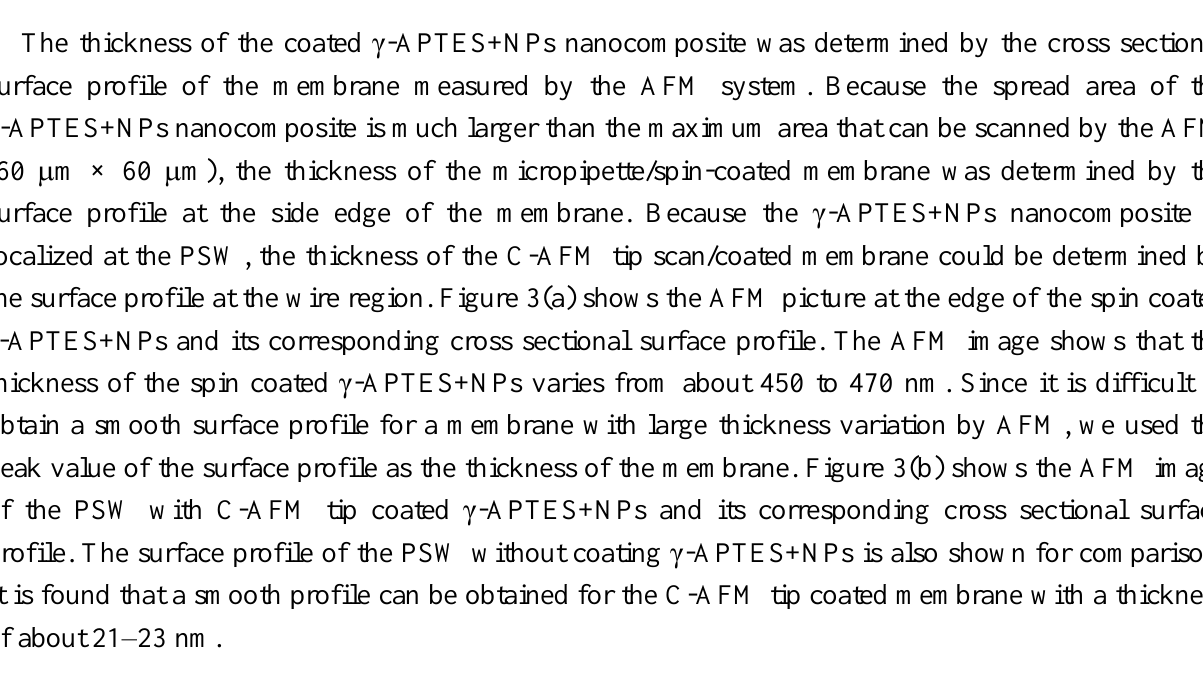
Figure 3. AFM pictures and surface profiles for the PSW coated with γ-APTES+NPs membrane using (a) micropipette/spin-coating, and (b) FIB processed C-AFM tip